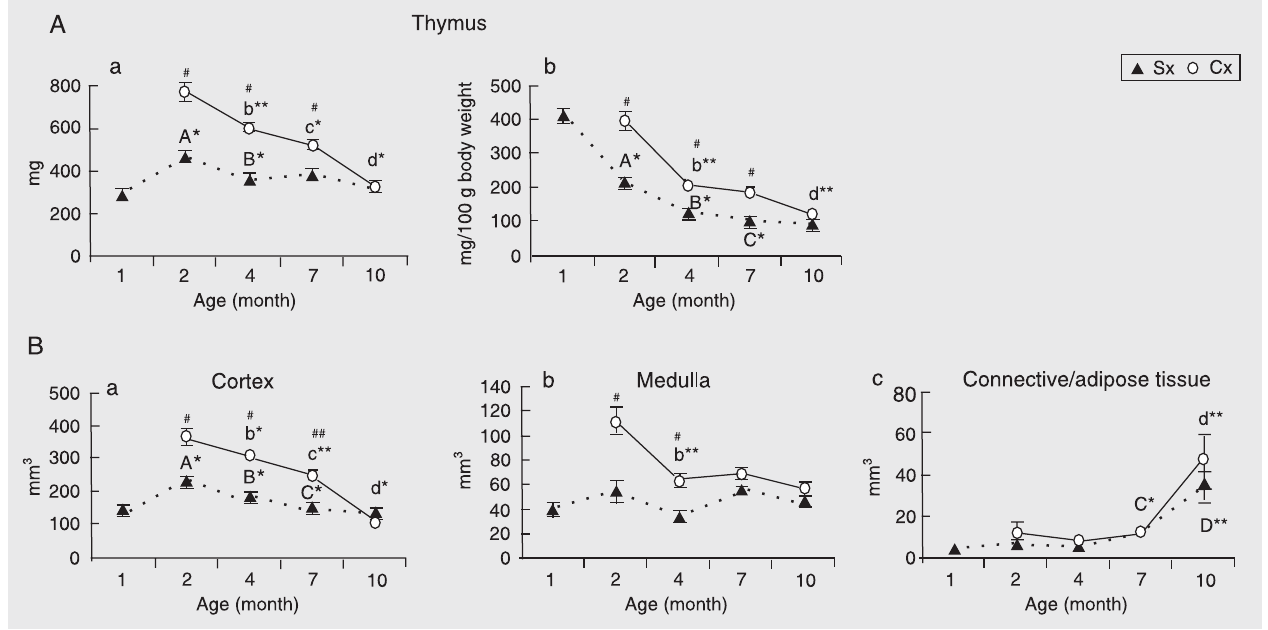
Figure 2. Age-related changes in A , absolute thymic weight (a) and relative thymic weight (b), as well as B , volume of different thymic compartments: (a) cortex, (b) medulla, and (c) connective/adipose tissue, in rats orchidectomized at the age of 30 days (Cx) and control animals (Sx). Data are reported as means ± SEM for N = 5. A 2-month-old Sx vs 30-day-old Sx; B 4-month-old Sx vs 2-month-old Sx; C 7-month-old Sx vs 4-month-old Sx; D 10-month-old Sx vs 7-month-old Sx; # Cx vs age-matched controls; b 4-month-old Cx vs 2-month-old Cx; c 7-month-old Cx vs 4-month-old Cx; d 10-month-old Cx vs 7- month-old Cx. *P < 0.05 and **P < 0.01; # P < 0.05 and ## P < 0.01 (Mann-Whitney